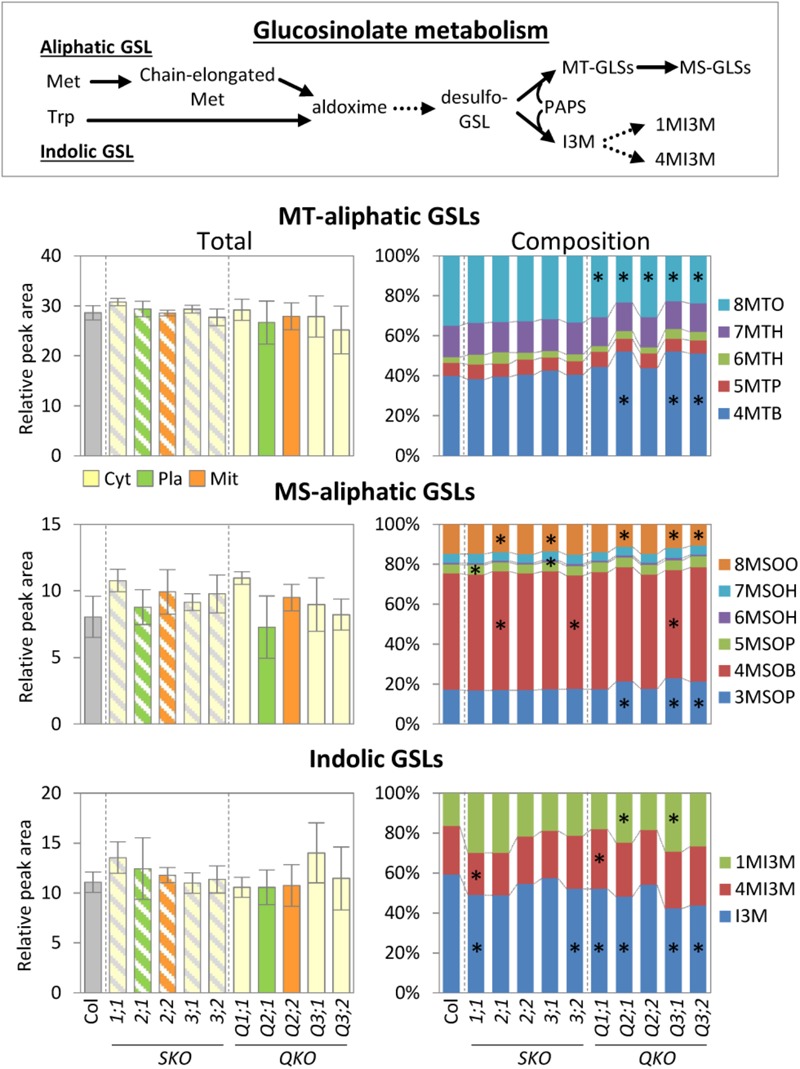
Accumulation of glucosinolate metabolism in serat mutants. Changes of total methylthioalkyl (MT-) aliphatic, methylsulfinylalkyl (MS-) aliphatic, indolic glucosinolate (GSL) contents in rosette leaves of 25-day-old plants. Contents of GSLs were determined by Liquid Chromatography/ElectroSpray Ionization-Mass Spectrometry (LC/ESI-MS) analysis. Peak area was normalized to sample fresh weight and the peak area of an internal standard. Data represent the mean (±SD) of three biological replicates. Percentages in stacked bar plots are displayed as mean percentage between three replicates. Differences between the wild type and serat mutants were analyzed using Student’s t-test and statistical significance was indicated (∗P < 0.05). Abbreviations: Met, methionine; Trp, tryptophan; PAPS, 3′-phosphoadenosine-5′-phosphosulfate; MT-aliphatic GLSs (4MTB, 5MTP, 6MTH, 7MTH, and 8MSOO, for 4-methylthiobutyl-GSL, 5-methylthiopentyl-GSL, 6-methylthiohexyl-GSL, 7-methylthioheptyl-GSL, and 8-methylthiooctyl-GSL, respectively); MS-aliphatic GLSs (3MSOP, 4MSOB, 5MSOP, 6MSOH, 7MSOH, and 8MSOO, for 3-methylsulfinylpropyl-GSL, 4-methylsulfinylbutyl-GSL, 5-methylsulfinylpentyl-GLS, 6-methylsulfinylhexyl-GLS, 7-methylsulfinylheptyl-GLS, and 8-methylsulfinyloctyl-GLS, respectively); indolic GLSs (I3M, 4MI3M, and 1MI3M, for indolyl-3-methyl-GSL, 4-methoxy-indolyl-3-methyl-GSL, and 1-methoxy-indolyl-3-methyl-GSL). Cyt, cytosol; Pla, plastids; Mit, mitochondria. SKO, serat single mutants (hatched bars); QKO, serat quadruple mutants (color bars).